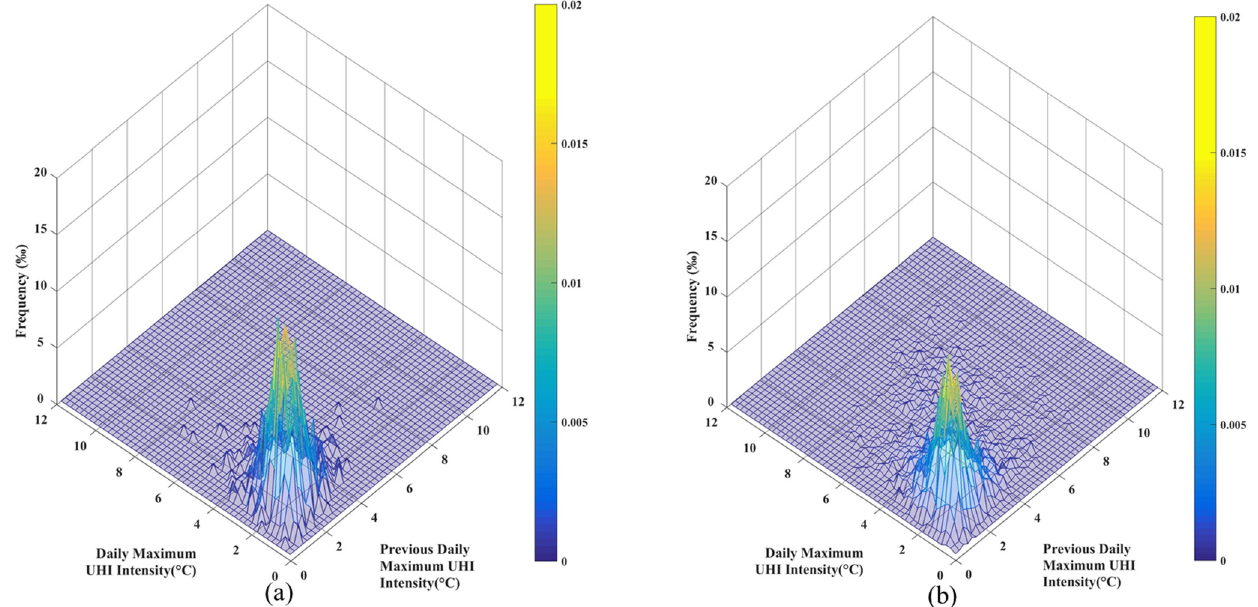
Figure 7. Frequency distribution of UHImax as a function of the previous-day UHImax (2002–2012, ( a ) summer, ( b ) annual).